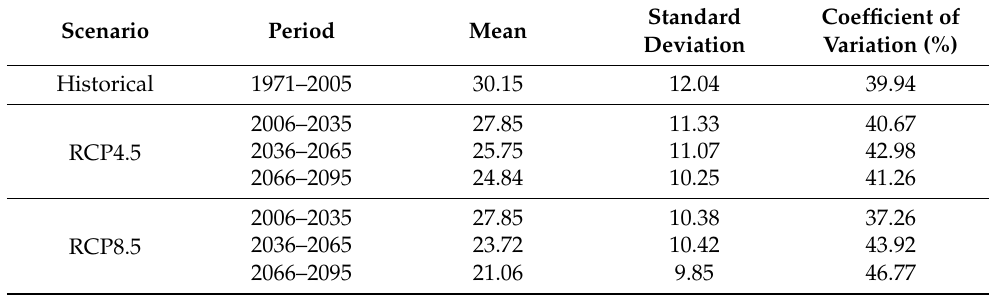
Table 3. Descriptive statistics of the De Martonne aridity index (I DM ) for each scenario and period.